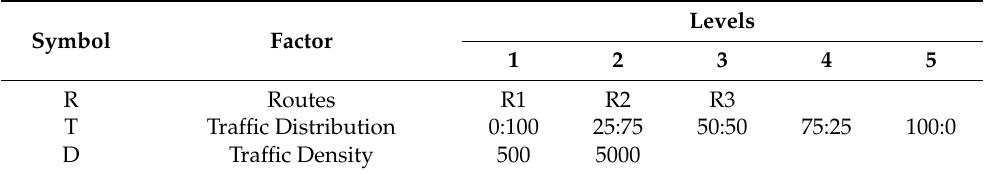
Table 7. Factors and their respective levels for trip time.